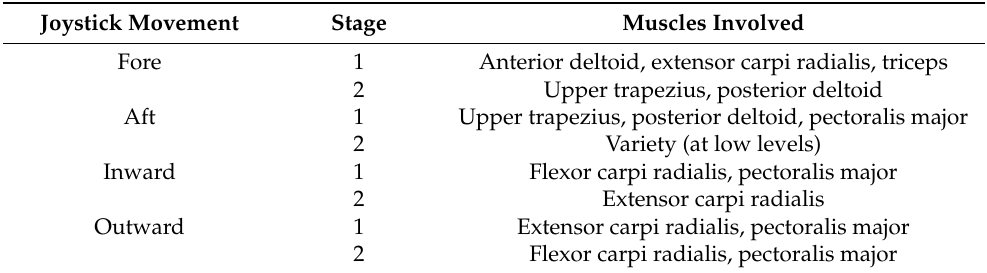
Table 1. Muscles involved in four different joystick movements [14]. Stage 1 involves movement from a neutral joystick position to the end point in the specified direction, and stage 2 involves joystick movement from the end point back to neutral